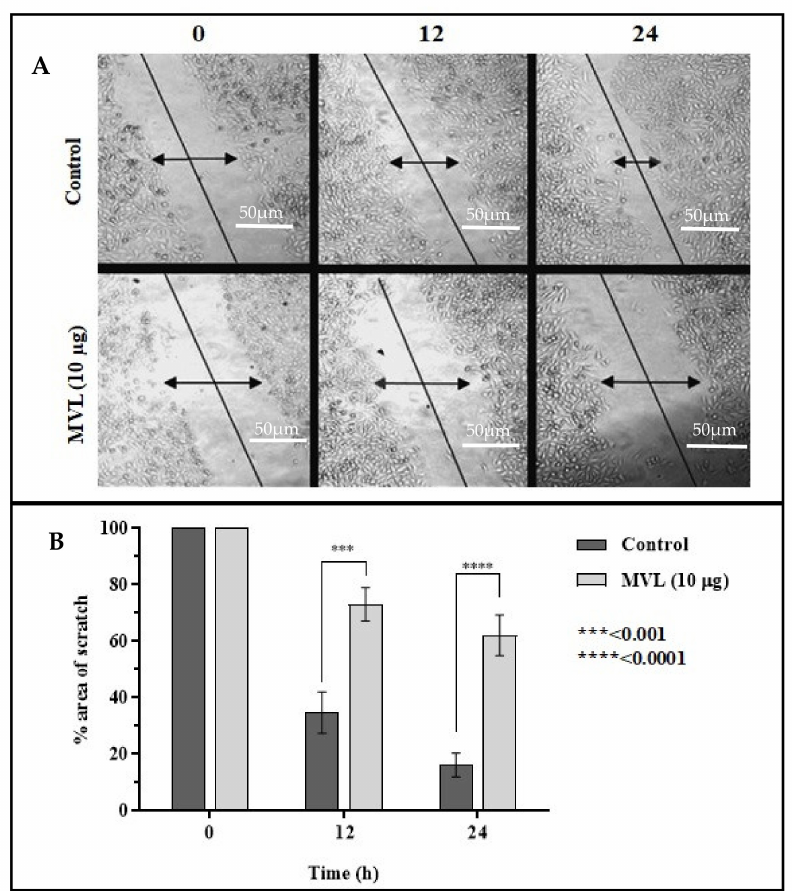
Figure 5. In vitro scratch assay on MVL treated prostate cancer cells. PC3 cells were plated in 6-well plates and scratched at the full confluence. Migration of cells to heal the area of the scratch was observed at 0 h, 12 h, and 24 h after treatment. Reduction in the area of the scratch was Photographed using Olympus CKX41 microscope and measured using ImageJ software. Data is mean ± SEM percent area of scratch in triplicate at ***: p < 0.001 and ****: p <